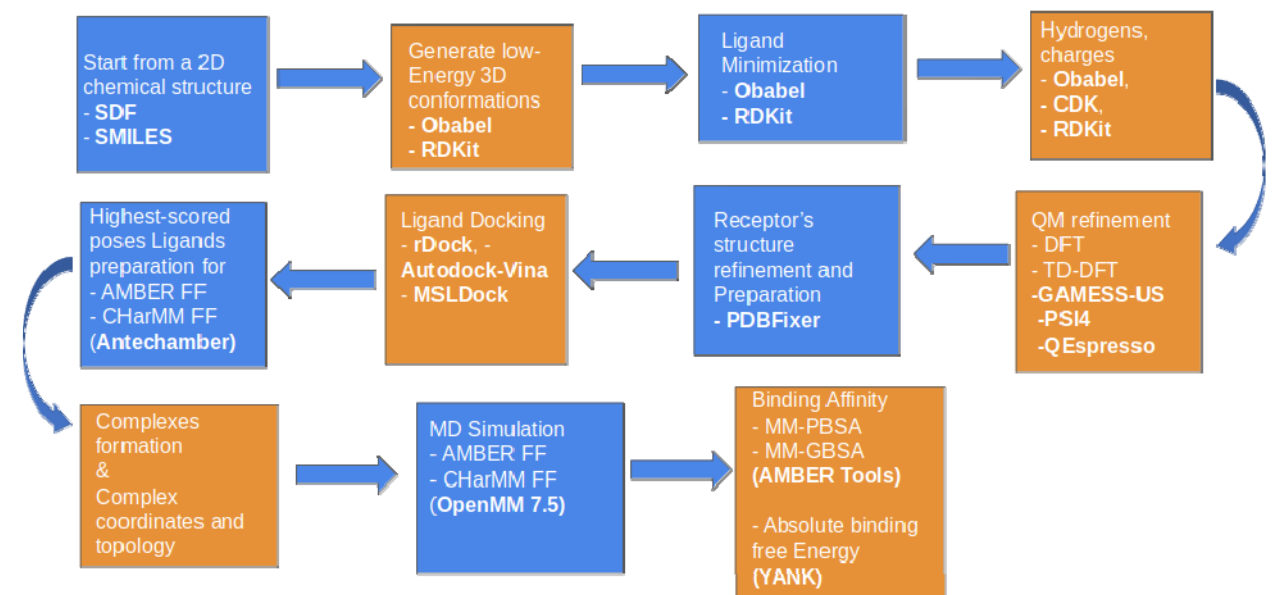
Figure 10. Enalos Asclepios KNIME workflow and its options for each node. A fully automated workflow for ligand-receptor preparation for docking, molecular dynamics simulations and binding affinity